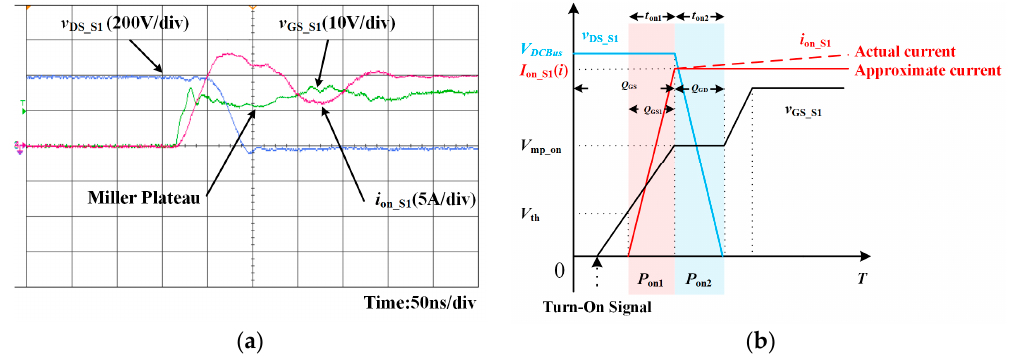
Figure 4. The waveforms during turn-on transition: ( a ) the measured waveform during the turn-on transition; and ( b ) the simplified diagram of the turn-on transition.